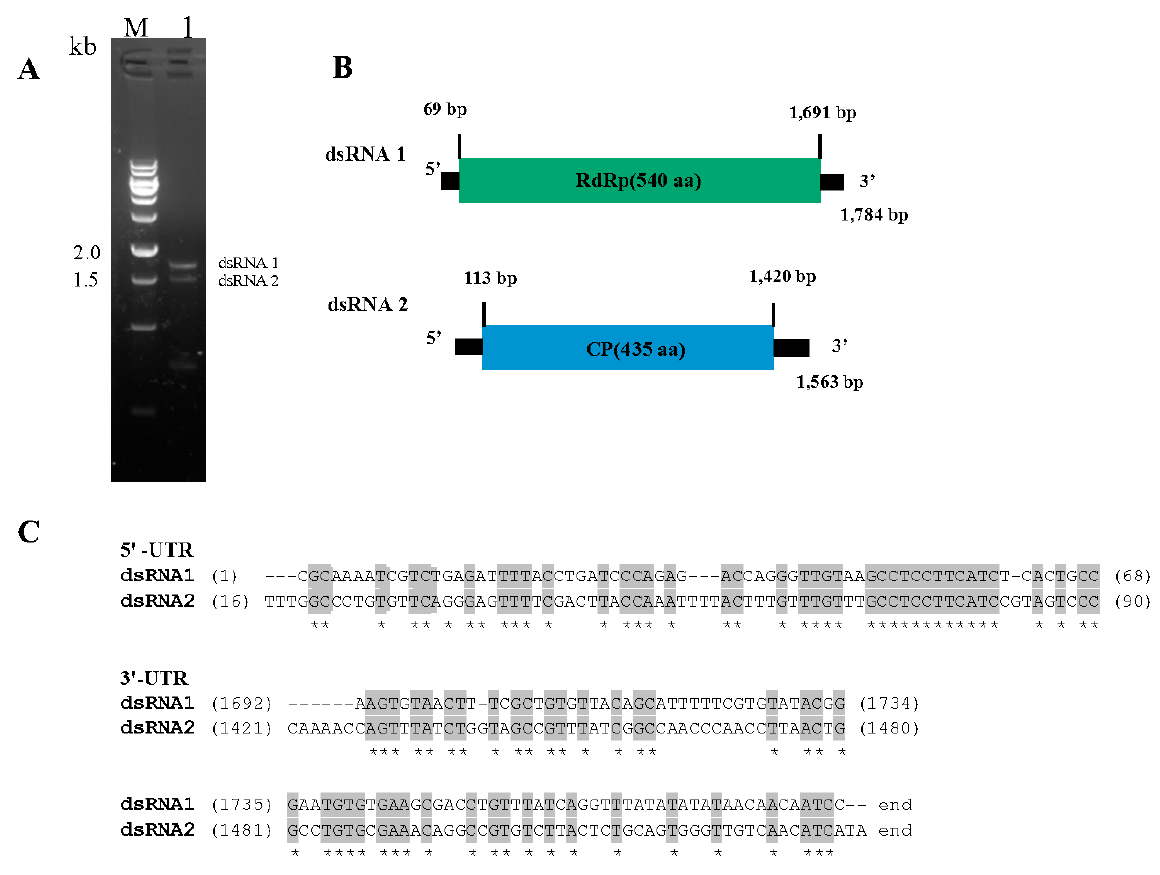
Figure 2. Characterization of CchPV1. ( A ) Electrophoresis of purified dsRNAs extracted from Cordyceps chanhua RCEF5997 in a 1.5% agarose gel. M, DNA marker; lane 1, dsRNA segments of RCEF5997. ( B ) Schematic representation of CchPV1. ( C ) Sequence alignment information of 5’-UTR and 3’-UTR of CchPV1 (ClustalX was used for sequence alignment). An asterisk indicates a position with a single, fully conserved residue. Colons and periods indicate conservation between groups with strongly similar properties (scoring > 0.5) and weakly similar properties (scoring ≤ 0.5), respectively, in the Gonnet PAM 250 matrix.